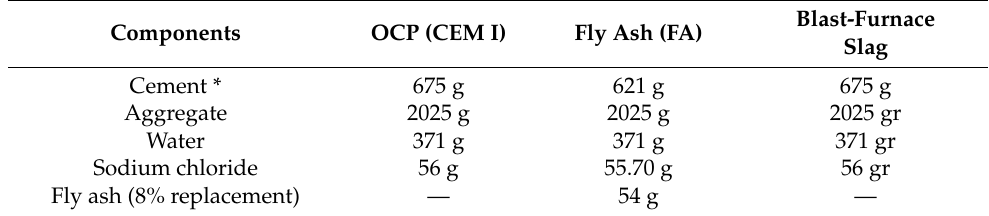
Blast-Furnace Slag